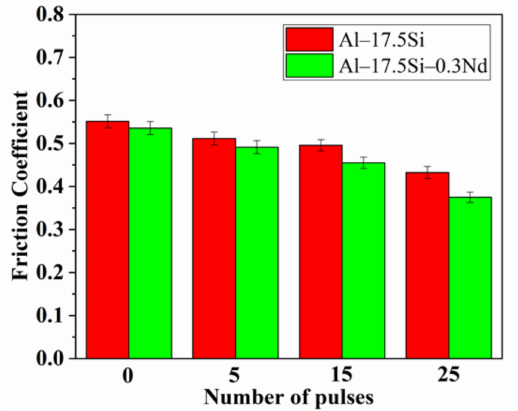
Figure 6. Friction-coefficient evolution of Al–17.5Si and Al–17.5Si–0.3Nd alloy surface with number of pulses.